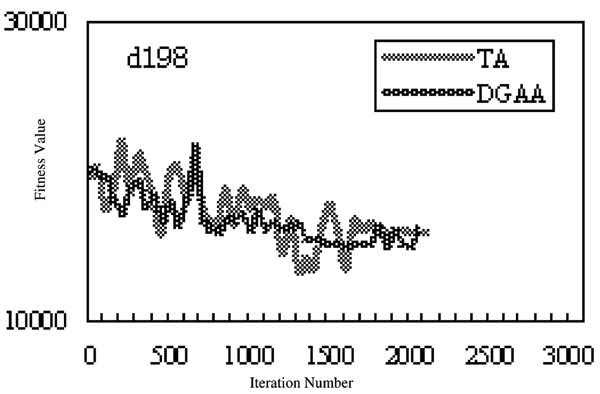
The evolutionary process for D198. Fig. 1 and Fig. 2 show the process of the best solution of problems for d198 and ry48p using TA and DGAA respectively. It is obvious that the speed of reaching the best solution using DGAA is higher than that of using TA.